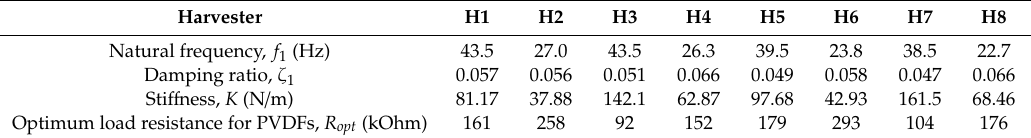
Table 2. Mechanical and electric properties of the harvesters considered in this study. Harvester